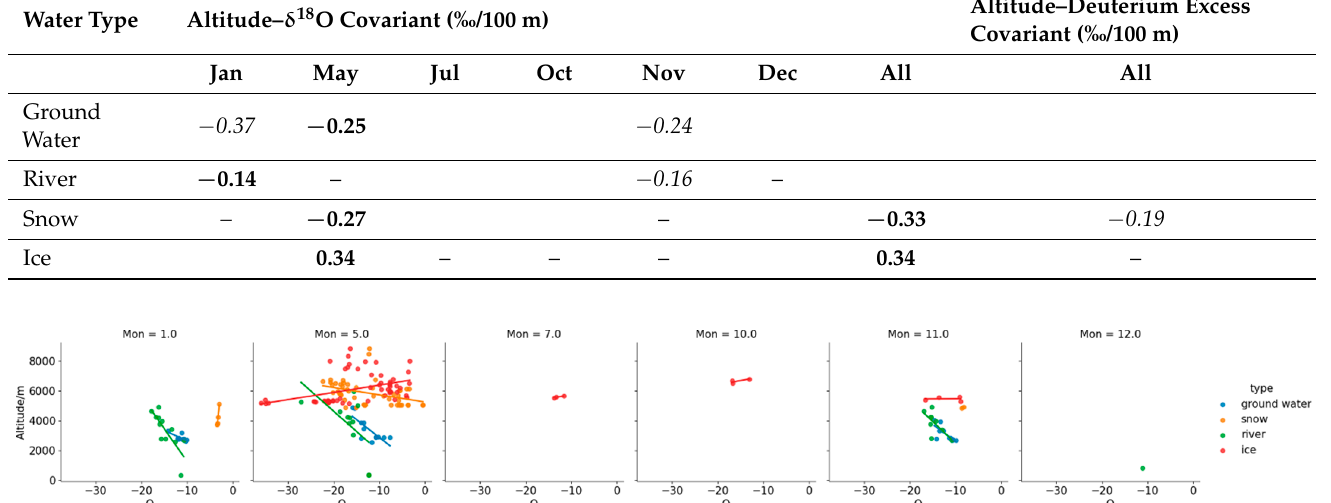
Table 1. Variation in water-stable isotopes with altitude. Bold numbers indicate correlation covariants significant at 99% confidence level, and italic numbers significant at 95% confidence level. ‘–’ indicates correlation insignificant due to too few samples.